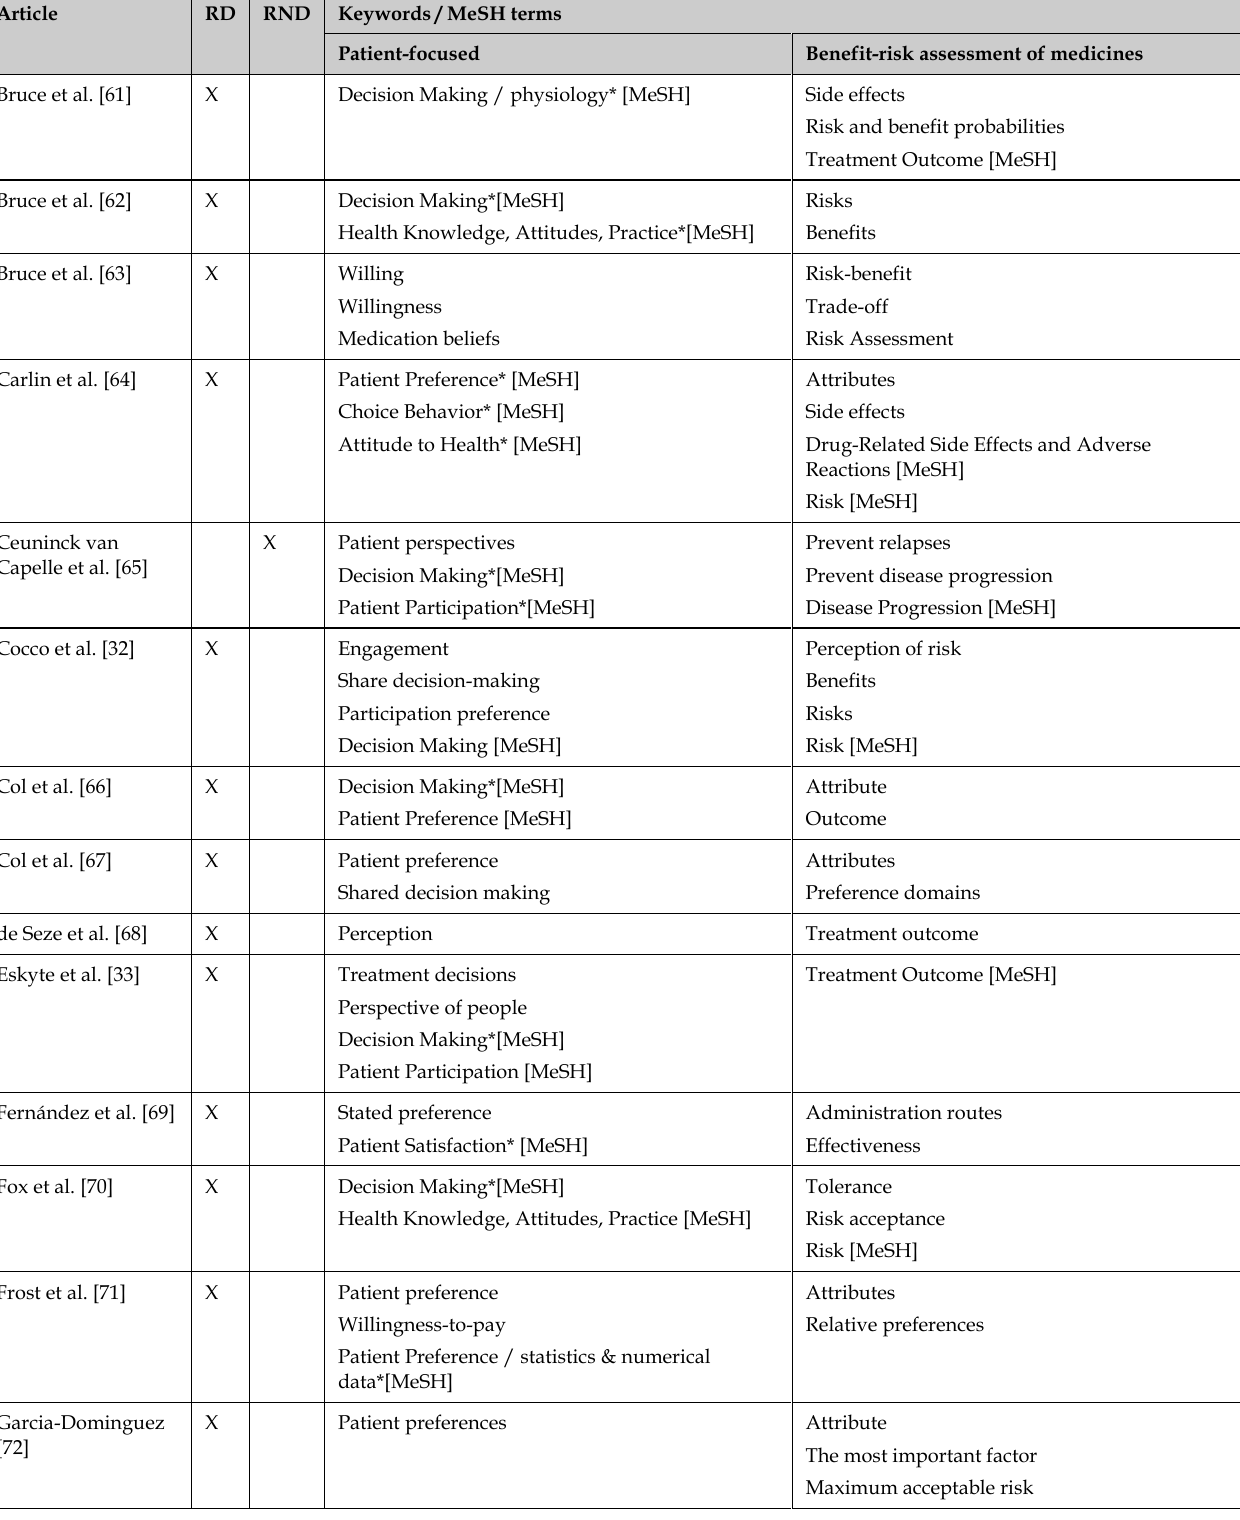
Table 3 Relevant articles on multiple sclerosis patients’ preferences regarding their medicines detected (RD) and not detected (RND) by the search strategy with corresponding keywords and MeSH terms